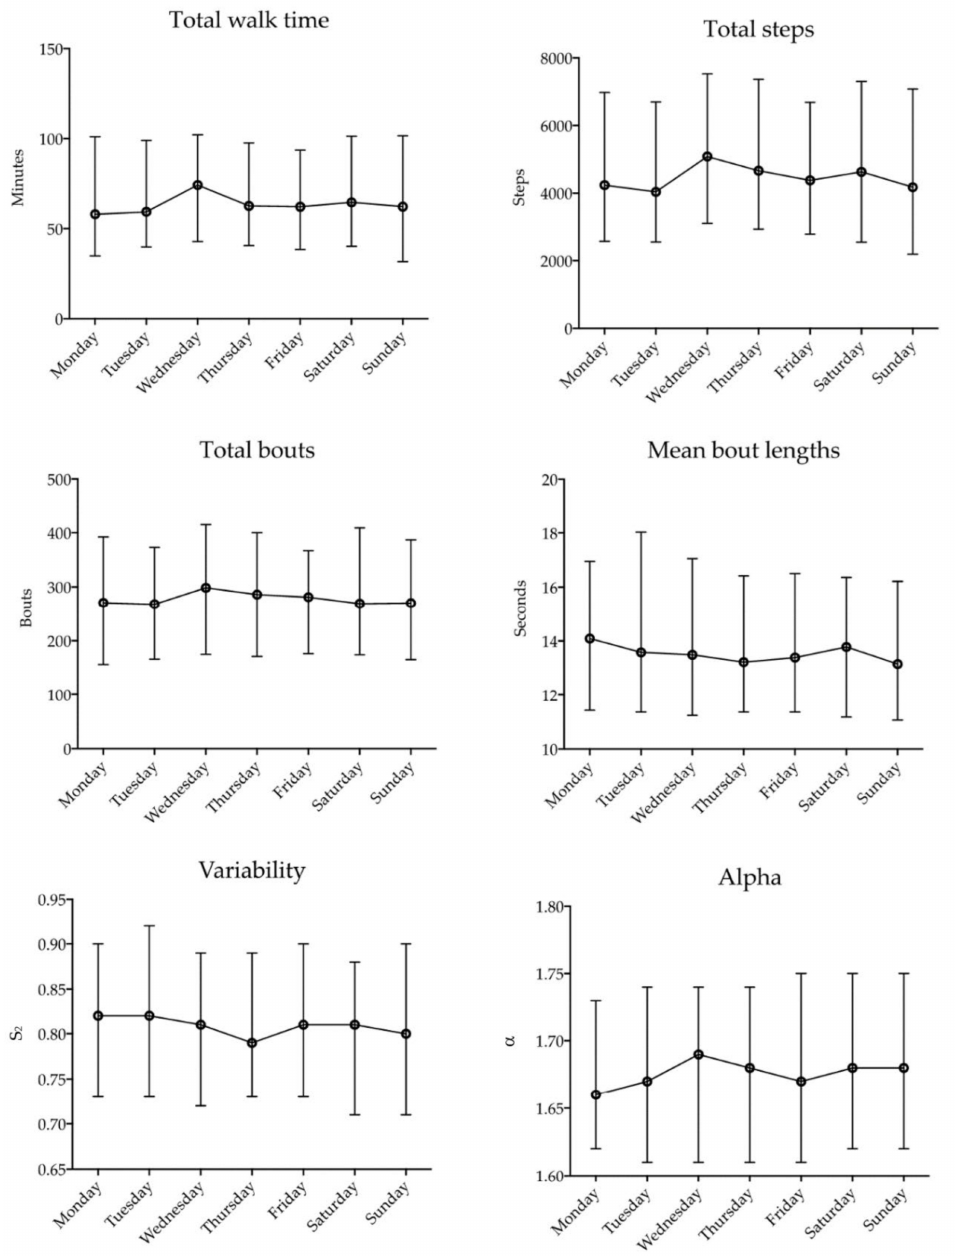
Figure 2. Median and interquartile range for total walk time, total steps, total bouts, mean bout lengths, variability and alpha for each day of the